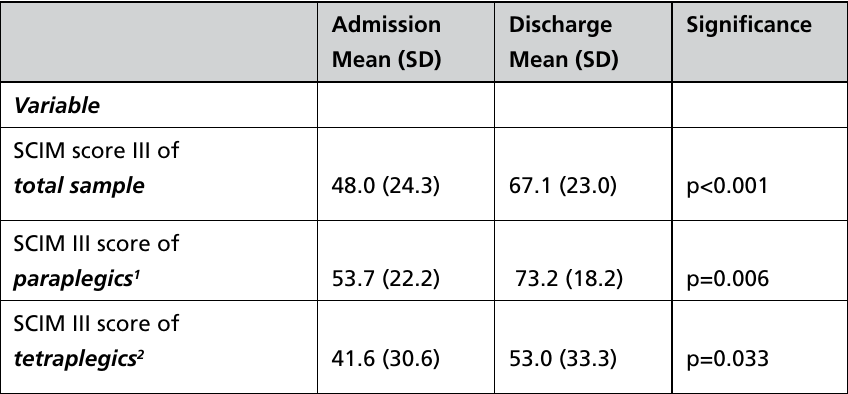
table 3: sciM iii mean scores, standard deviation and mean difference of the total sample- and sub-classification of